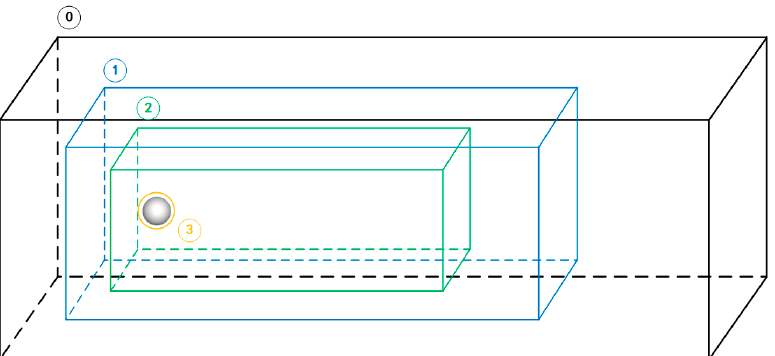
Figure 24. The local refinement structure of multiple enclosing boxes and fitting body meshes was set in the rectangular computational domain. The structure diagrams 0, 1 and 2 indicate the geometry of the enclosing box, respectively. Point 3 indicates the local mesh refinement of the four round boundaries extrapolating the six-layer mesh. The mesh resolution of all four regions depended on the mesh resolution of its upper layer. The grid size of the enclosing box 0 was fixed as 80 × 48 × 48. The region of (0) + (3) denotes the schematic of case1, (0) + (1) + (3) denotes the schematic of case2 and (0) + (1) + (2) + (3) denotes the schematic of case3.